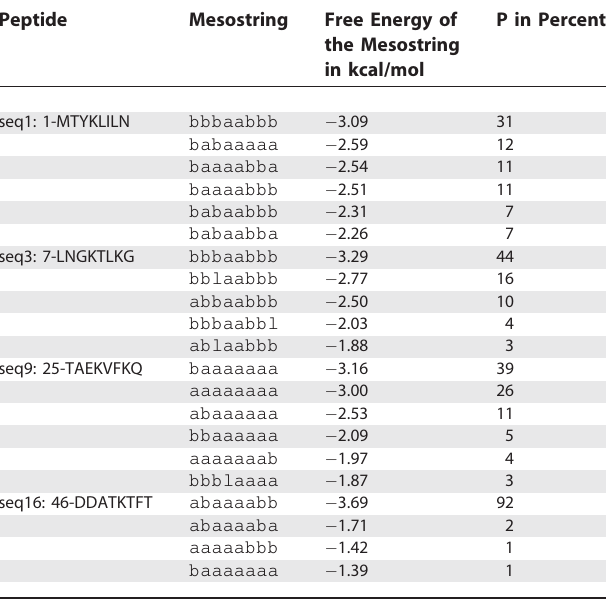
Table 1. Mesostrings of Various Peptides from Protein G Peptide Mesostring Free Energy of the